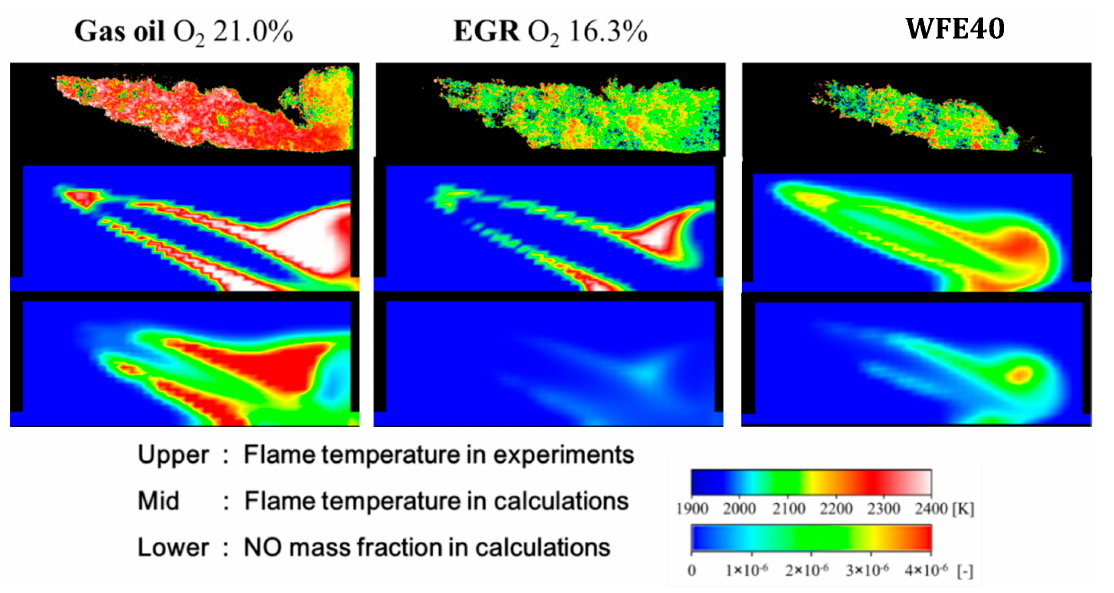
Figure 14. The calculated flame temperature and NO compared to the actual photos at 10 °CA ATDC.